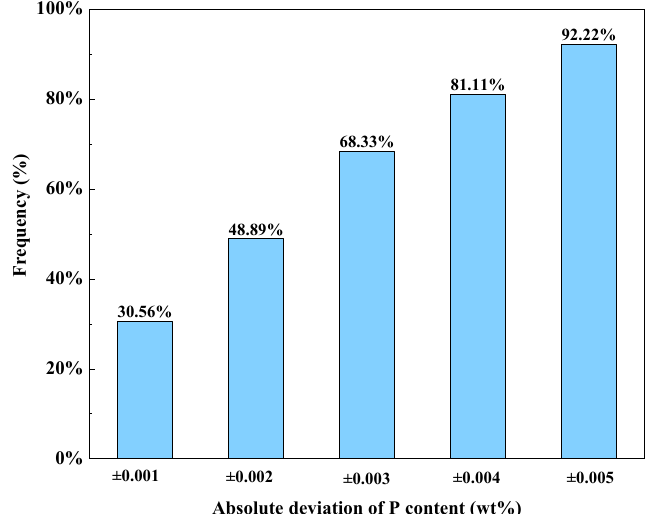
Figure 8. Frequency of absolute deviation of P content in the prediction model optimized with con- sumption of oxygen divided into